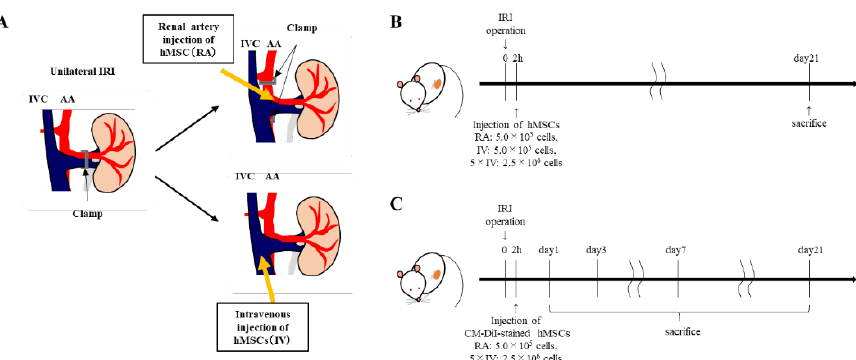
Figure 1. Ischemia-reperfusion injury (IRI) experimental protocol. ( A ) After the left kidney was visualized, the left renal artery was clamped for 60 min using atraumatic vascular clamps to establish the model of IRI. Sixty minutes after reperfusion, rats were injected through the renal artery or inferior vena cava. ( B ) After IRI, rats in the renal artery (RA) group were injected with 5 × 10 5 hMSCs diluted in 0.2 mL PBS through the renal artery, while rats in the IV group were injected with the same amount of cells via the inferior vena cava. Rats in the 5 × IV group were intravenously injected with 2.5 × 10 6 hMSCs diluted in 0.3 mL PBS. To evaluate the antifibrotic effect of hMSCs, rats were sacrificed on day 21. ( C ) To determine the engraftment period and localization of hMSCs in IRI kidneys, rats in the RA group, received an intra-arterial injection of 5 × 10 5 CM-DiI-stained hMSCs diluted in 0.2 mL PBS, while rats in the 5 × IV group received 2.5 × 10 6 CM-DiI-stained hMSCs intravenously. Rats were sacrificed on days 1, 3, 7, 21, and 42 post-IRI. Abbreviations: IRI, ischemia-reperfusion injury; hMSCs, human mesenchymal stem cells; RA, renal artery injection; IV, intravenous injection.